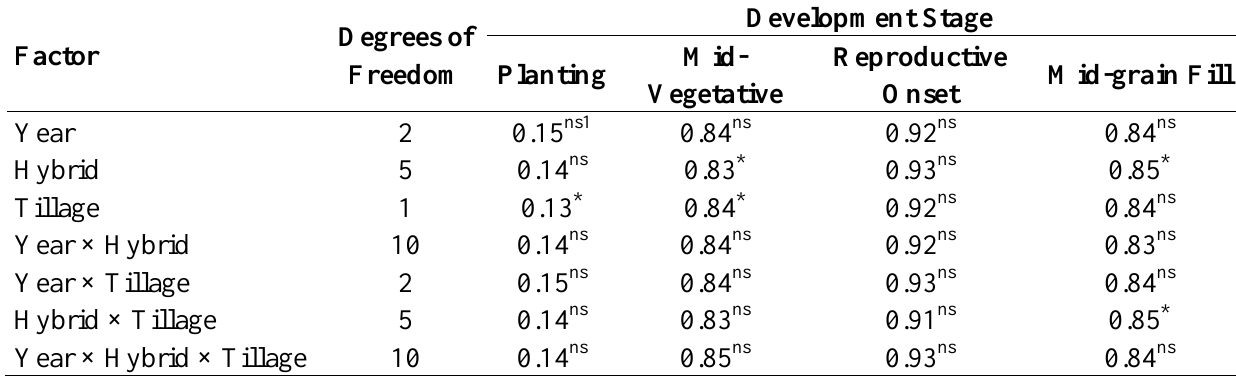
Table 3. Mean values of NDVI observations over six corn hybrids grown in two tillage systems for the period from 2002 to 2004 for four development periods and the ANOVA for the comparison of the treatments and interactions.